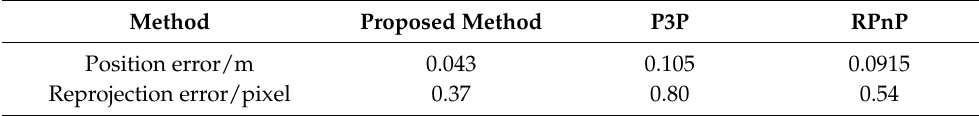
Table 2. The position error and reprojection error in the first